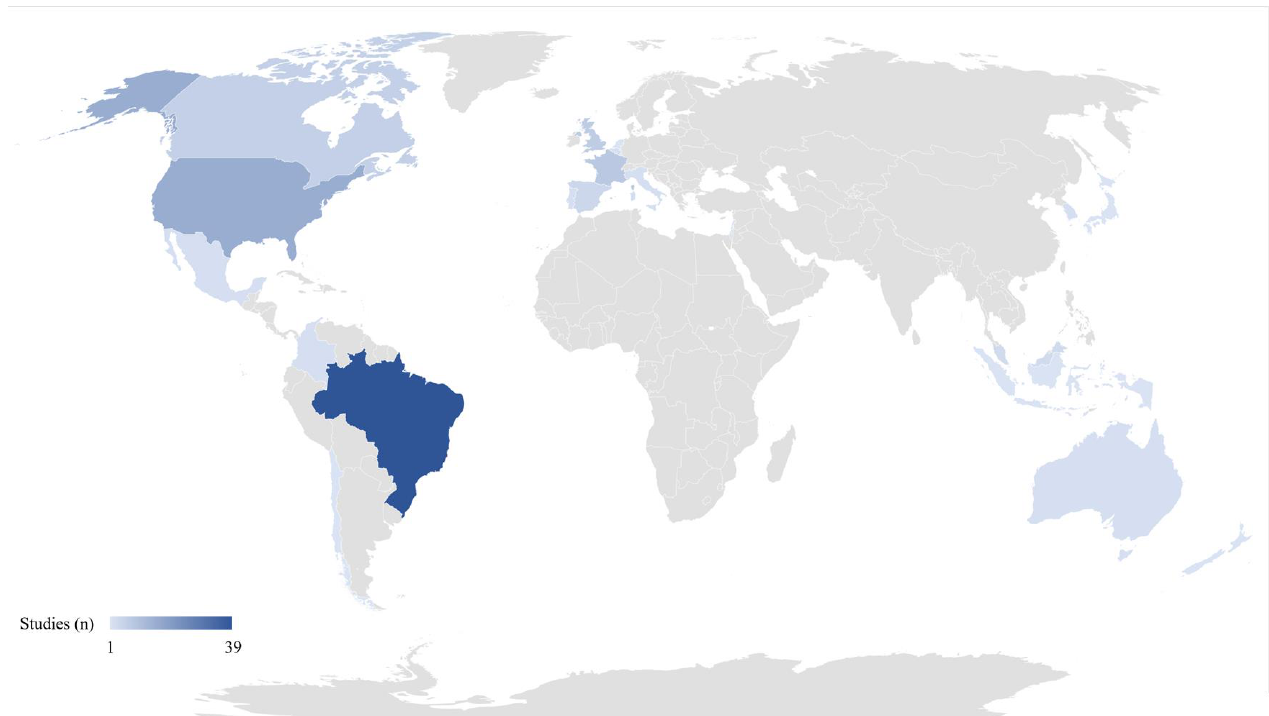
Figure 2. Countries in which studies on consumption levels for UPF were performed; the darker the blue, the higher the number of studies conducted.